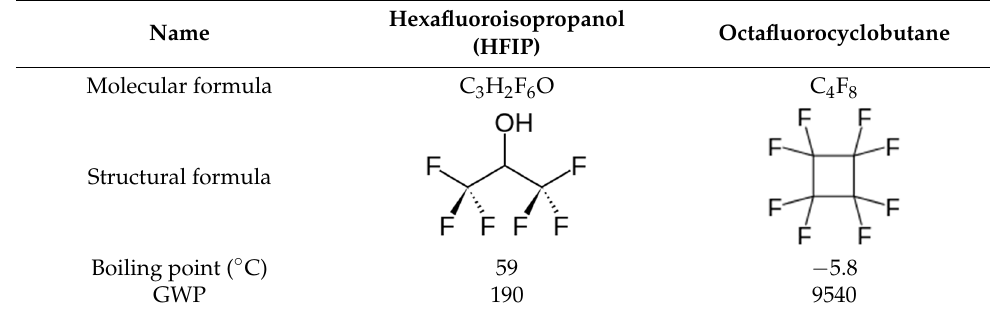
Table 1. The properties of HFIP and C 4 F 8 .